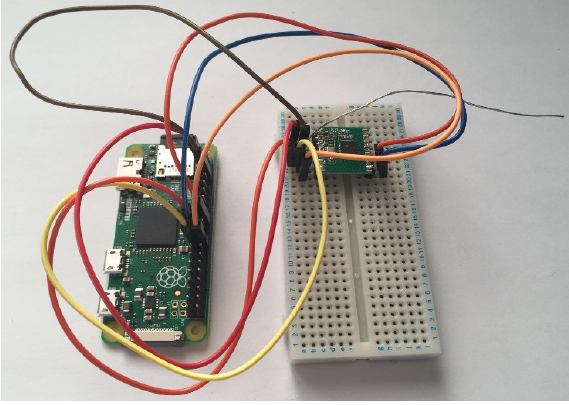
Figure 18. Photo showing the Traffic Generator Node.